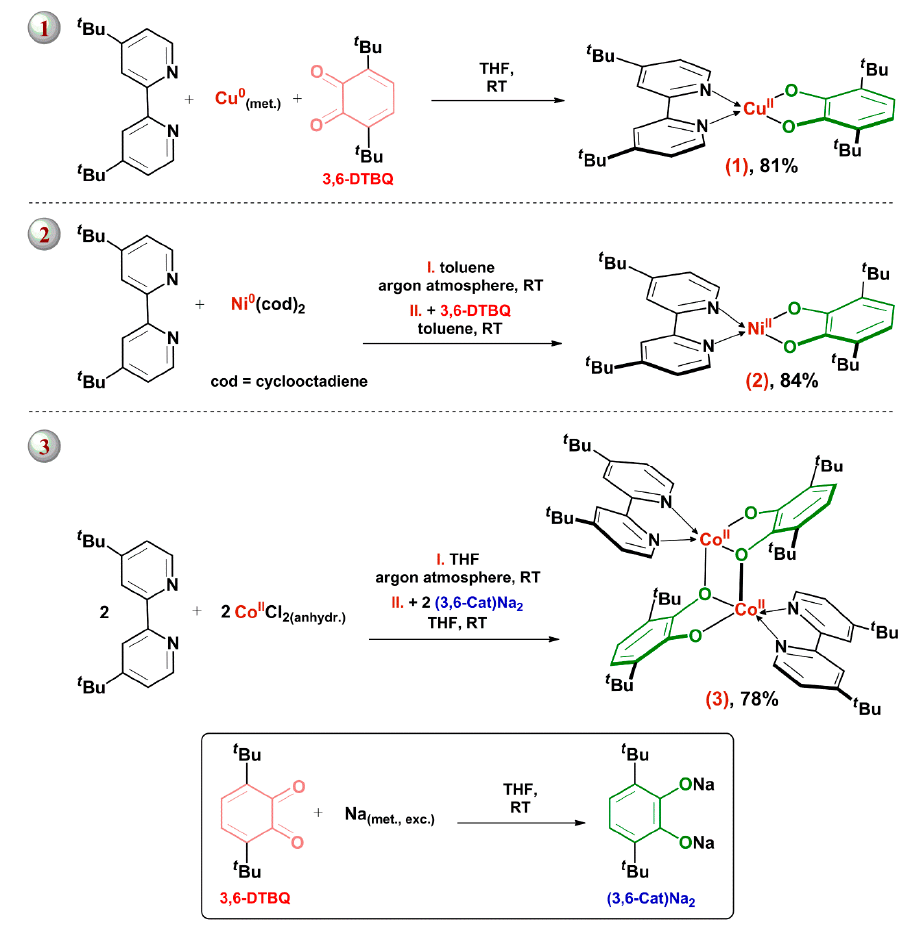
Figure 1. Synthetic routes for complexes 1 – 3 .